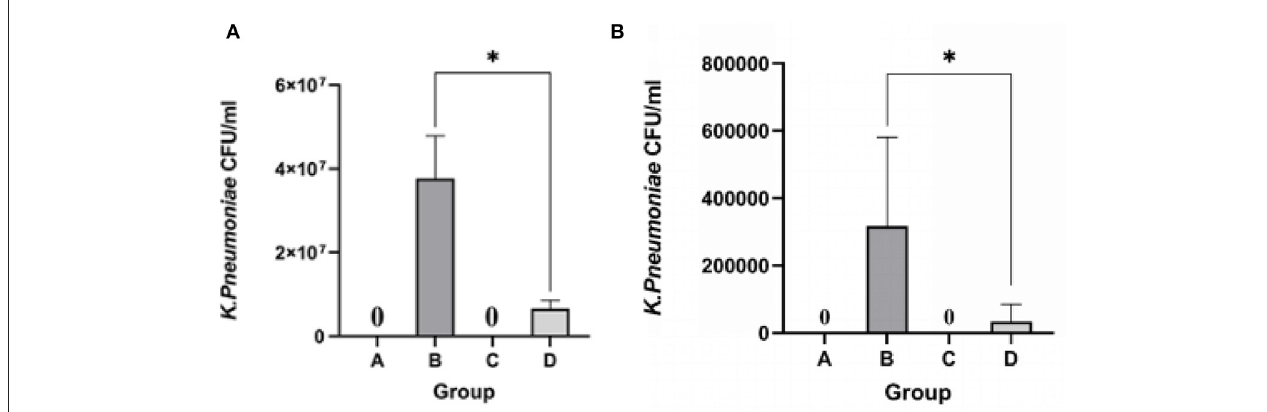
FIGURE 8 | Count of bacterial load in lung and liver tissues of mice. (A) Bacterial load in lung tissues; (B) bacterial load in liver tissues; * p <